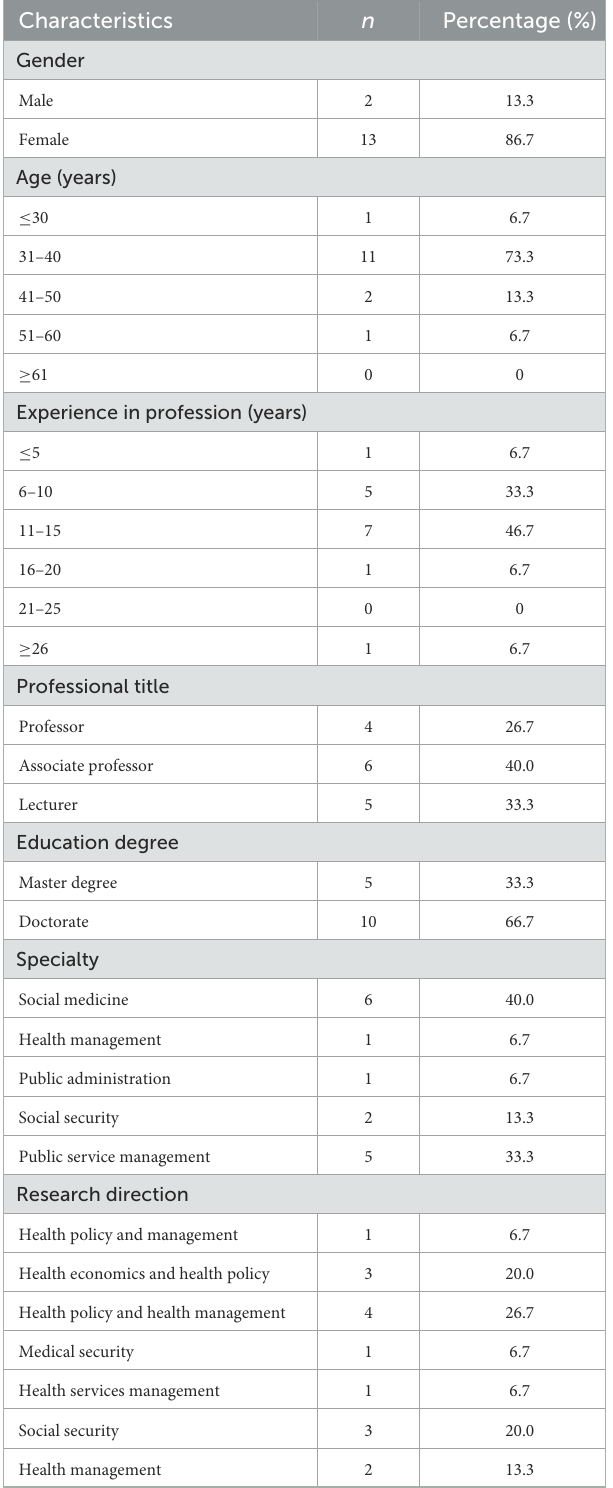
TABLE 2 Demographic characteristics of the Delphi panel ( N =